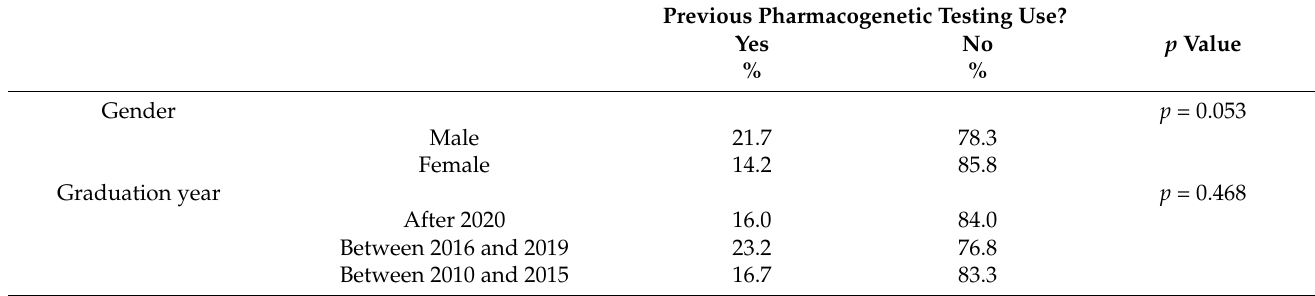
Table 3. Comparison of pharmacogenetic testing